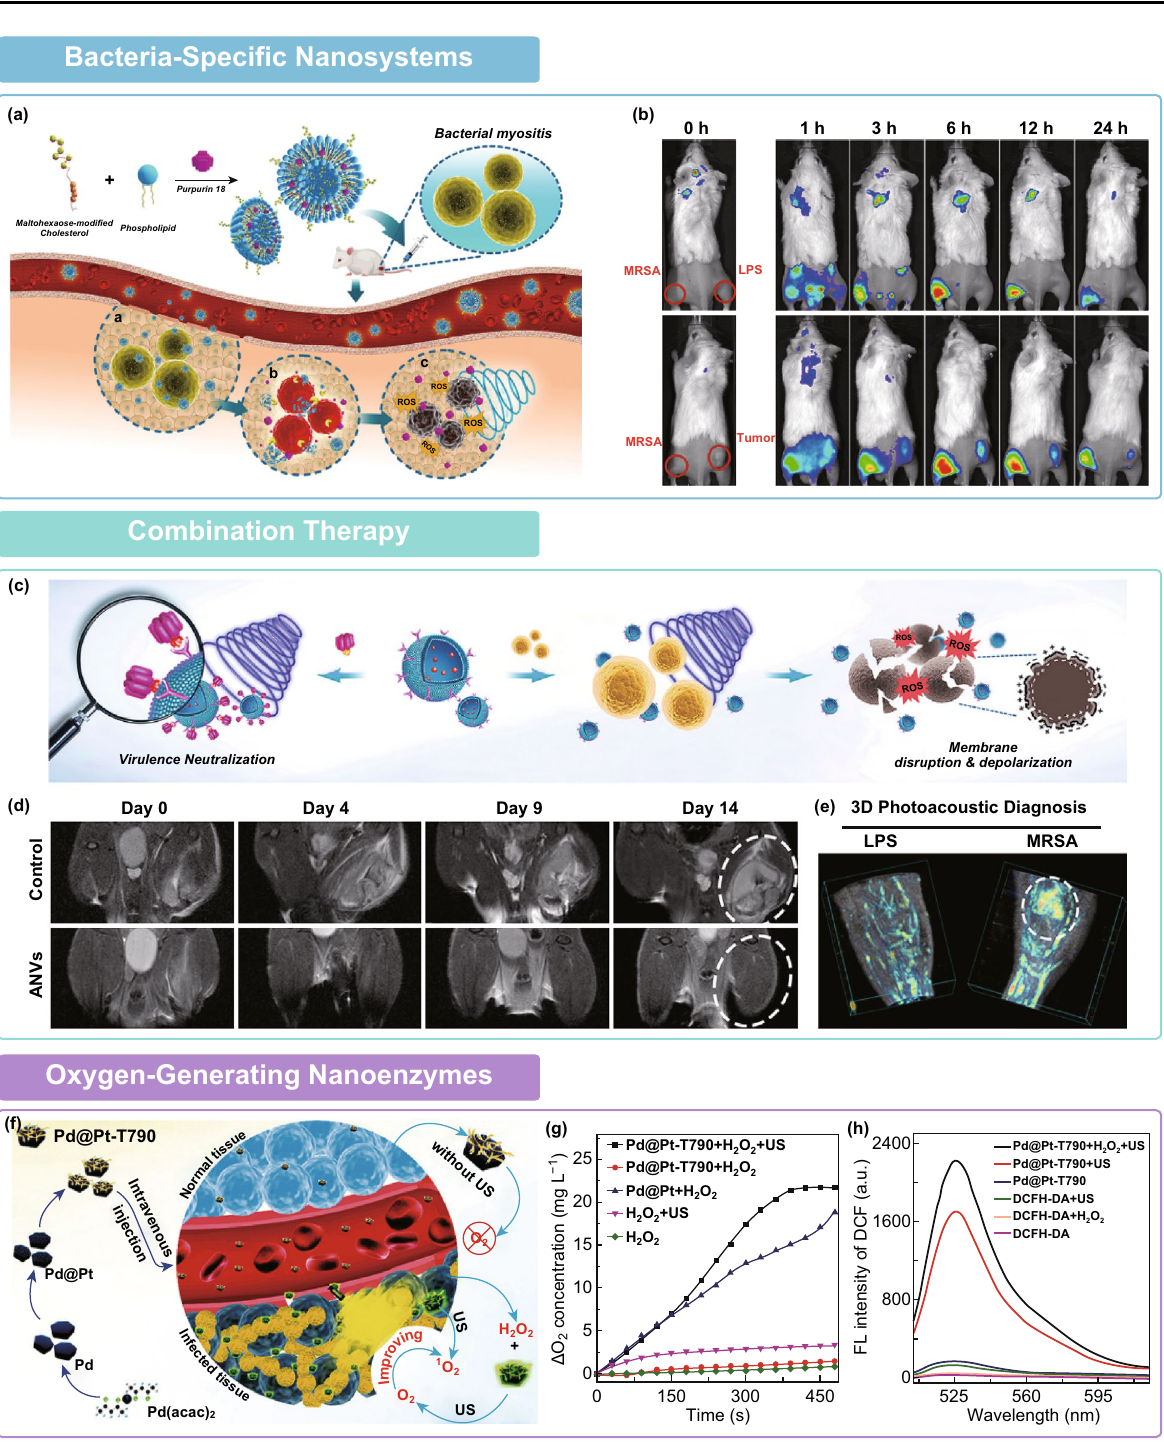
Fig. 9 a Scheme illustration of MLP18 nanoliposomes for diagnosis and eradiation of bacterial infection. b NIR fluorescence images of MRSA and LPS infected mice or MRSA and 4T1 tumor-bearing mice model after MLP18 injection [99]. Copyright 2019 American Chemical Society. c Sche- matic illustration of the antivirulence and antibacterial mechanism of ANVs. d Representative magnetic resonance images of MRSA-infected mice within 14-day post-injection of ANVs. e 3D photoacoustic images of MRSA and LPS infected thighs from ANVs-treated mice [19]. Copyright 2019 Wiley-VCH. f Schematic illustration of Pd@Pt-T790 nanoenzyme for ultrasound-switchable oxygen generation and aSDT enhancement. The gener- ation of g oxygen and h ROS by Pd@Pt-T790 nanoenzyme without or with ultrasound exposure [109]. Copyright 2020 American Chemical